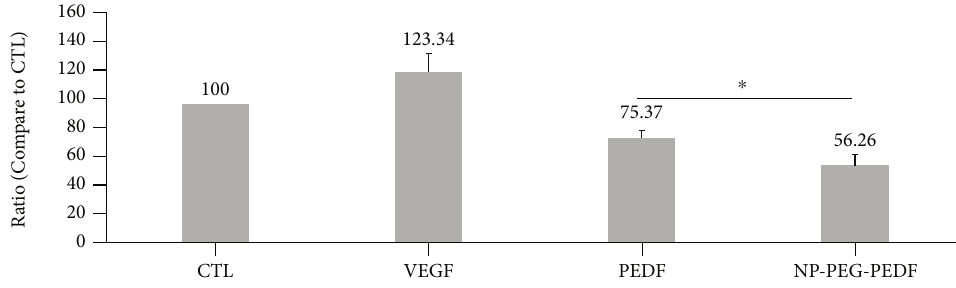
Figure 8: Statistical results of the length of tube formation under di ff erent treatments. DMEM+10% FBS control was set to 100%. ∗ p < 0 : 05 .